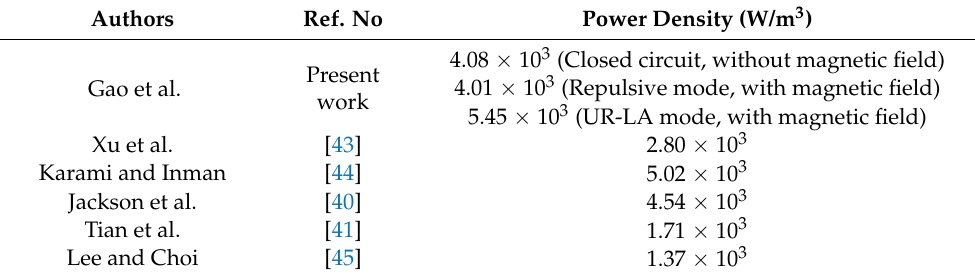
Table 2. Comparison of output power